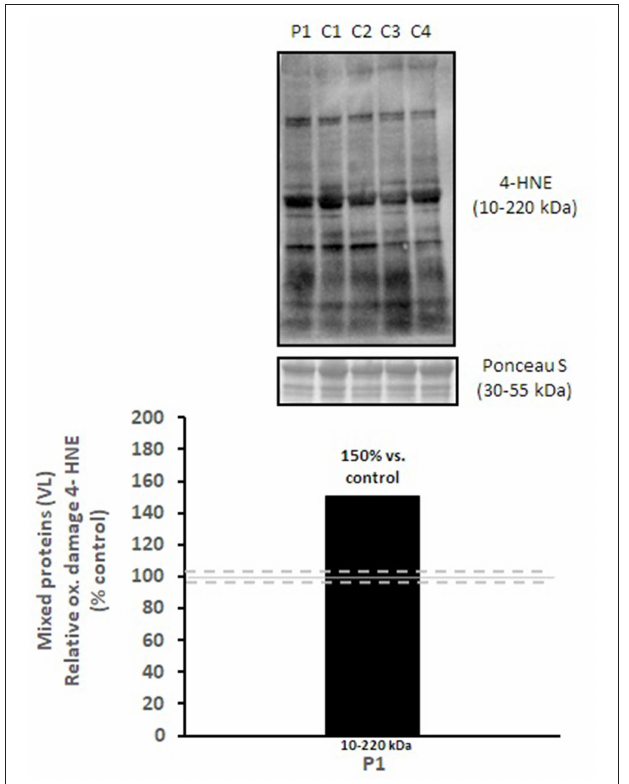
FIGURE 3 | Oxidative damage of mixed proteins in vastus lateralis muscle. 4-HNE levels of mixed proteins in vastus lateralis muscle were normalized to total protein (Ponceau S) and presented as a percentage of healthy, gender, and age-matched controls ( N = 4). Solid gray line indicates normal 4-HNE levels (e.g., control mean is 100%) and dashed lines are bidirectional standard errors calculated from the absolute values, control mean, and N .